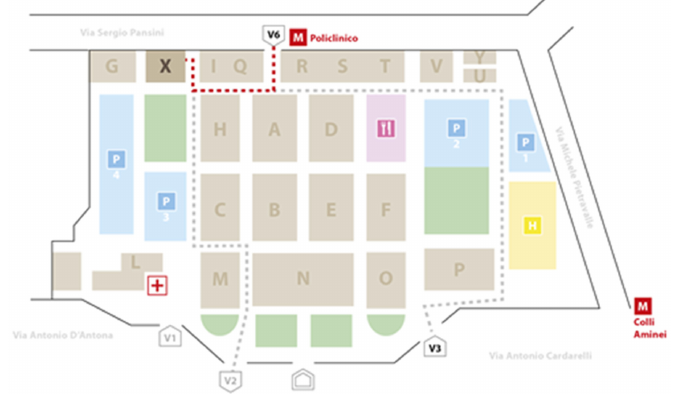
Figure 1. A.O.R.N. “A. Cardarelli” of Naples.